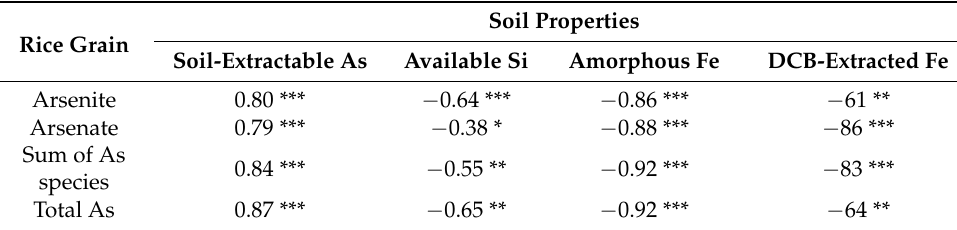
Table 3. Correlation coefficients between As species in rice grain and soil chemical properties. Soil Properties Rice Grain Soil-Extractable As Available Si Amorphous Fe DCB-Extracted Fe Arsenite 0.80 *** − 0.64 *** − 0.86 *** − 61 ** Arsenate 0.79 *** − 0.38 * − 0.88 *** − 86 *** Sum of As 0.84 *** − 0.55 ** − 0.92 *** − 83 *** species Total As 0.87 *** − 0.65 ** − 0.92 *** − 64